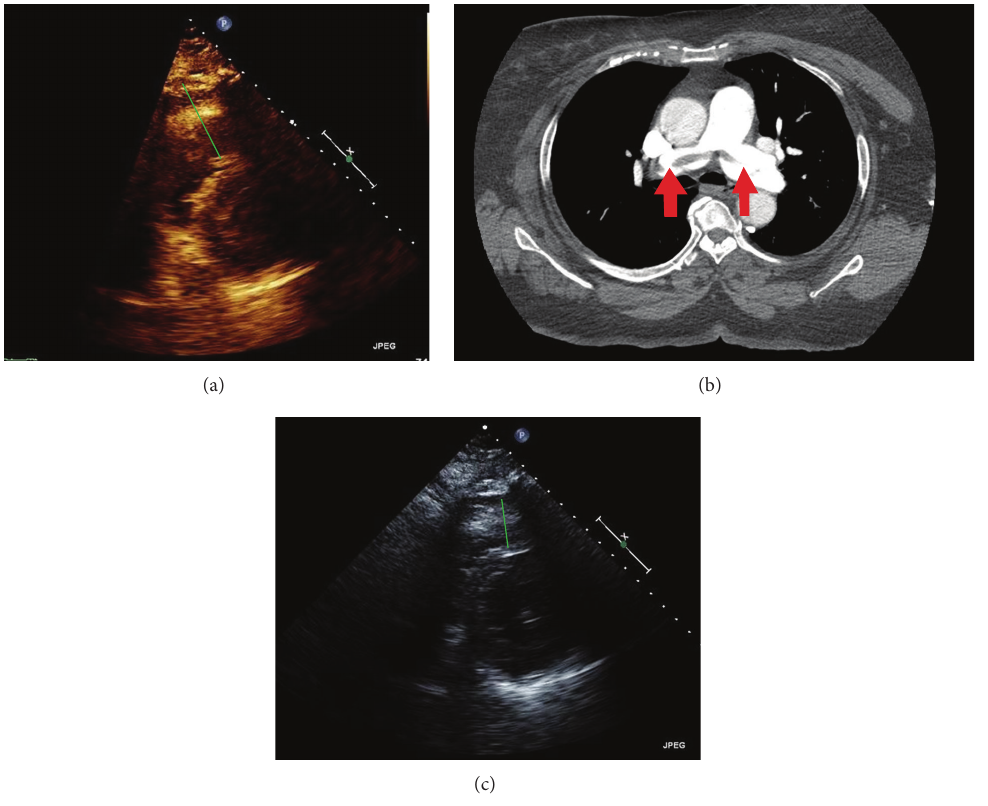
Figure5: (a)Theechocardiogram showsdilated right ventricle(green line). (b)TheCT-scanshowsan evidence of saddleemboli (redarrows). (c) There was a marked improvement in right ventricle size after the treatment (green